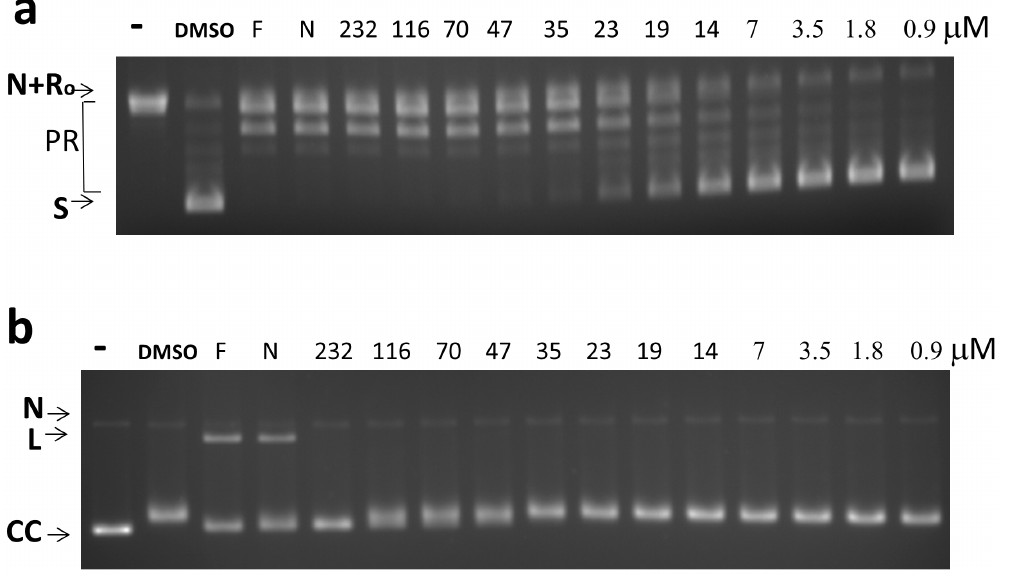
Figure 7. Effect of anziaic acid on E.coli DNA gyrase activity. (a) Assay of supercoiling activity with 1 U of enzyme and 250 ng of relaxed plasmid DNA substrate. (b) DNA cleavage assay with 5 U of enzyme. Gel electrophoresis was carried out in the presence of 0.5 m g/mL ethidium bromide. Positive controls – F: 100 m M levofloxacin; N: 100 m M norfloxacin. S: supercoiled plasmid DNA substrate. N: nicked plasmid DNA. Ro: Relaxed closed plasmid DNA. PR: partially relaxed plasmid DNA. L: linear DNA CC: covalently closed circular DNA.